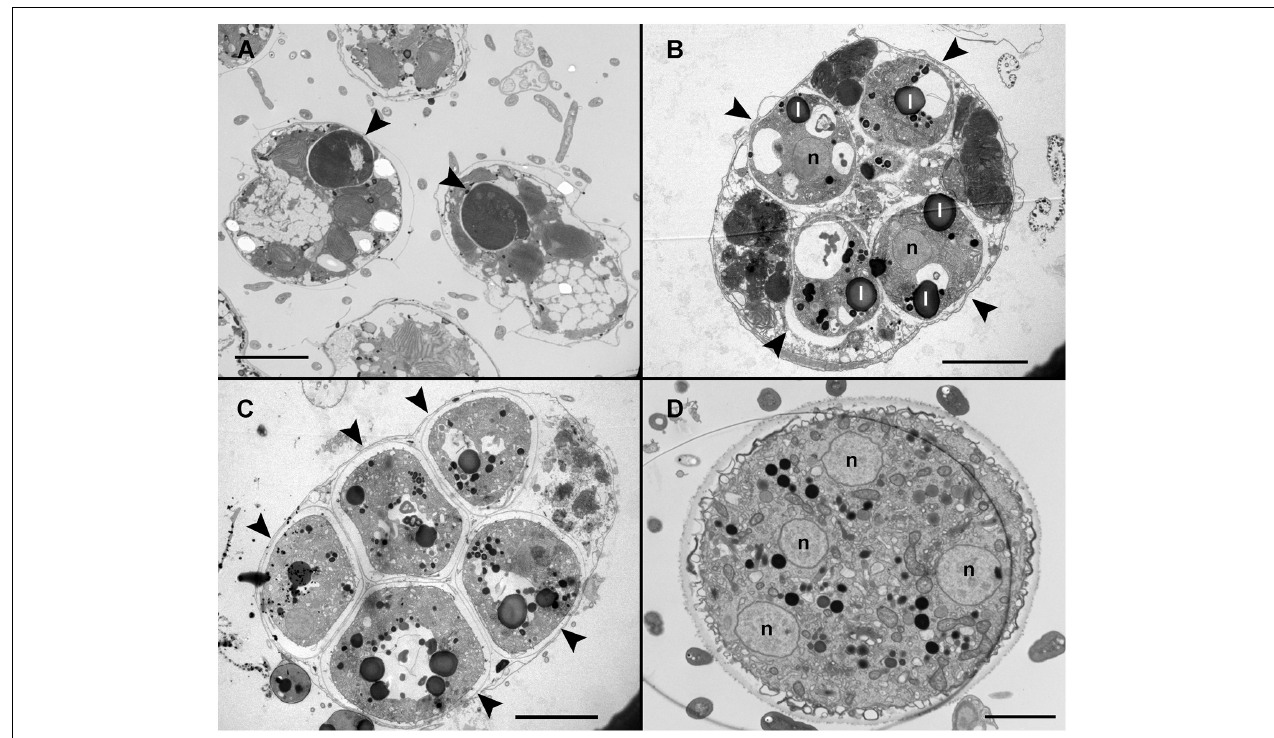
FIGURE 4 | Transmission electron microscopy (TEM) of Maranthos nigrum showing the parasitoid’s life-cycle stages from early trophont to early sporont. (A) Alexandrium minutum cells with an early trophont of M. nigrum inside their host cytoplasm (arrowheads). (B) Four trophonts (arrowheads) developing inside a dinoflagellate cell. (C) Five late trophonts (arrowheads) after having completely consumed the host cytoplasm and occupying the whole dinoflagellate volume. The external membranes of the different trophonts are in close contact. (D) Early sporont showing several nuclei. Abbreviations: l = lipid granule; n = nucleus. Scale bars (A) = 10 µ m, (B,C) = 5 µ m, and (D) = 2 µ